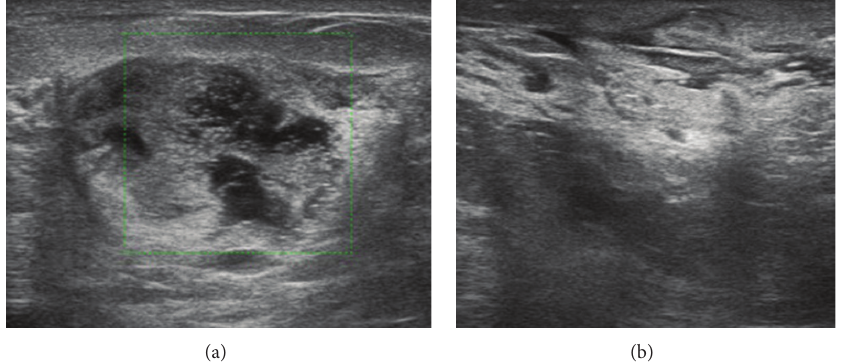
Figure 4: US of the right breast shows a complex heterogeneous mass with hypoechogenicity within, localized in the outer quadrants (a) and a linear hypoechogenicity extending to the skin (fistulous tracts) in the upper inner quadrant and a diffused subcutaneous edema